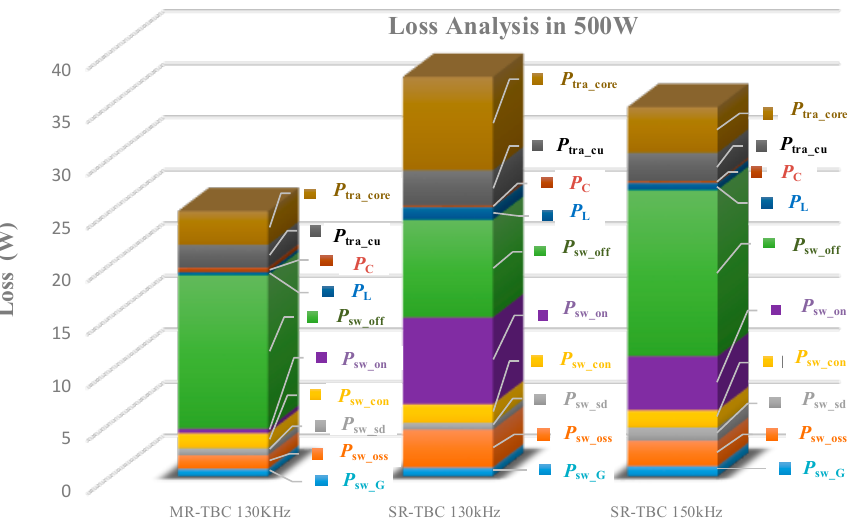
Figure 13. Loss calculation comparison of MR-TBC and SR-TBC under 500 W.